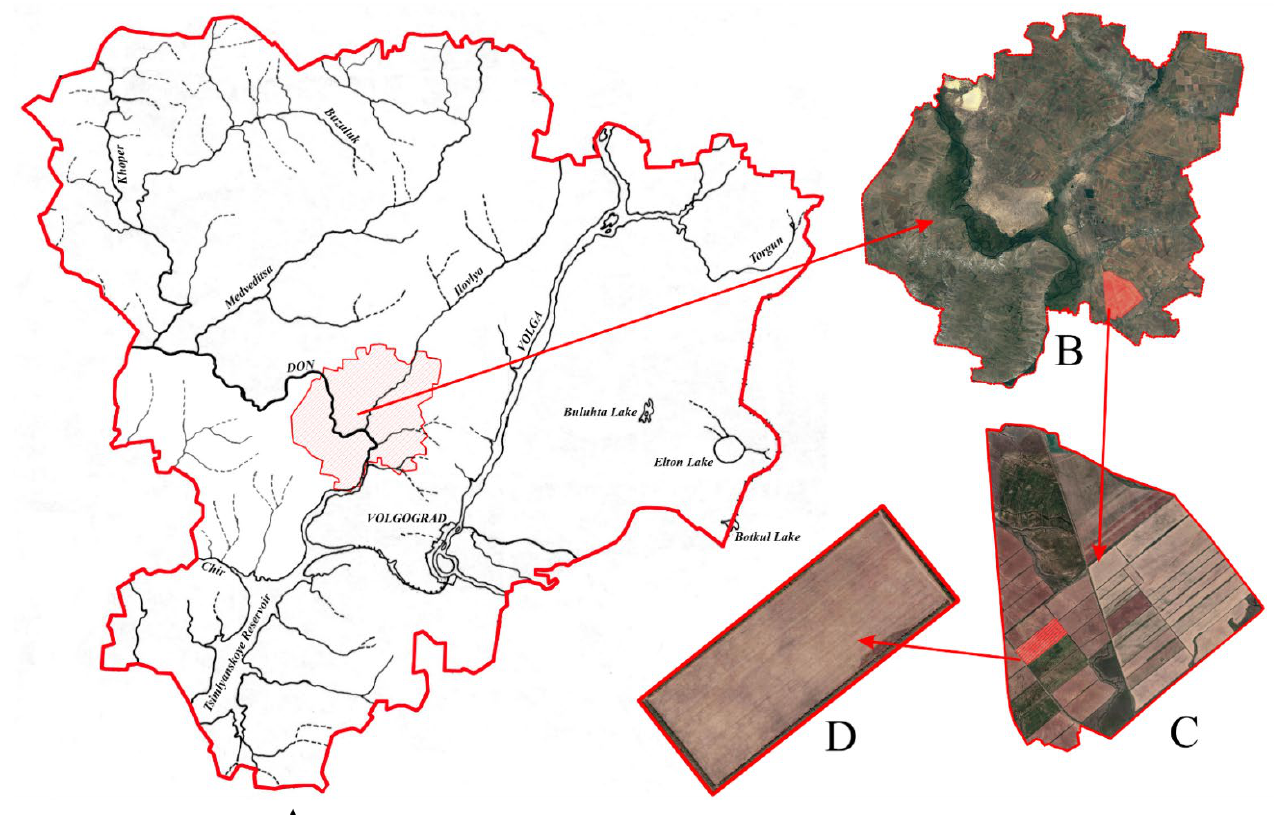
Figure 1. Schematic map of the research object location: ( A ) Volgograd region; ( B ) Ilovlinsky district; ( C ) Kachalino test site; ( D ) test field.